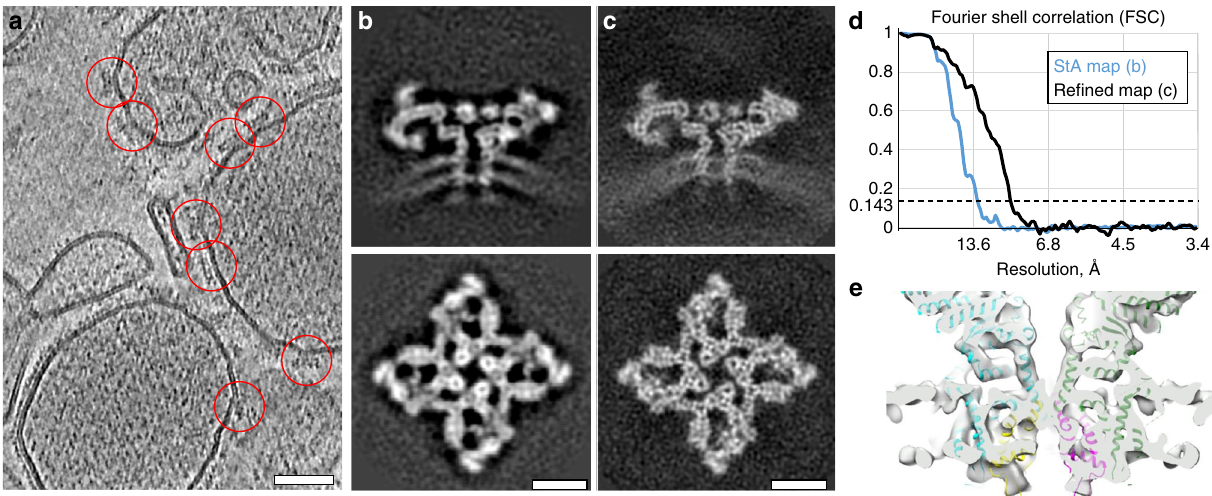
Fig. 4 Structure of RyR1 in native membranes at subnanometer resolution. a A slice through a tomogram of native SR vesicles extracted from rabbit skeletal muscle. Red circles highlight RyR1 particles on the membrane of SR vesicles. Scale bar: 50 nm. b Slices through a subtomogram average generated from 2715 particles at a resolution of 12.9 Å. c Slices though a re fi ned map at 9.1 Å resolution generated from 2563 particles. Scale bars in b , c : 10 nm. d Corresponding FSC curves between the respective independently processed half-sets. e A volume rendered visualization of the transmembrane domain of the re fi ned map of RyR1 with a rigidly fi t atomic model (PDB ID: 5TB2 from reference 43